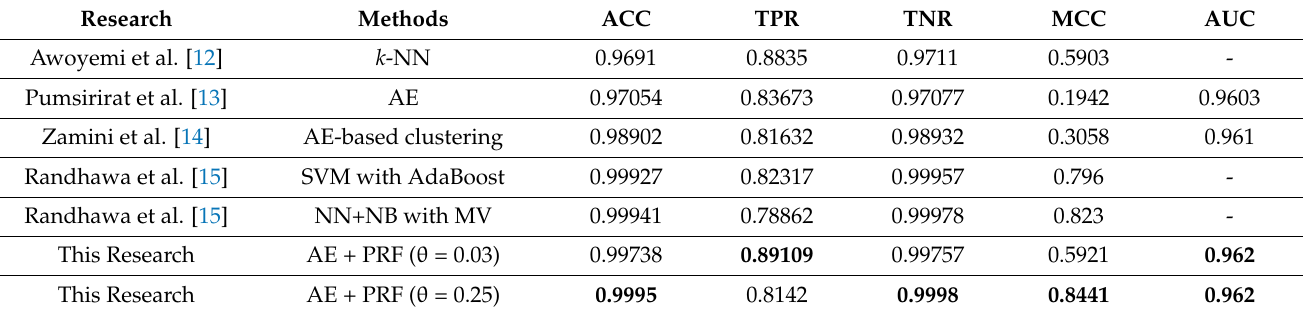
Table 3. Performance comparisons of AE-PRF and related